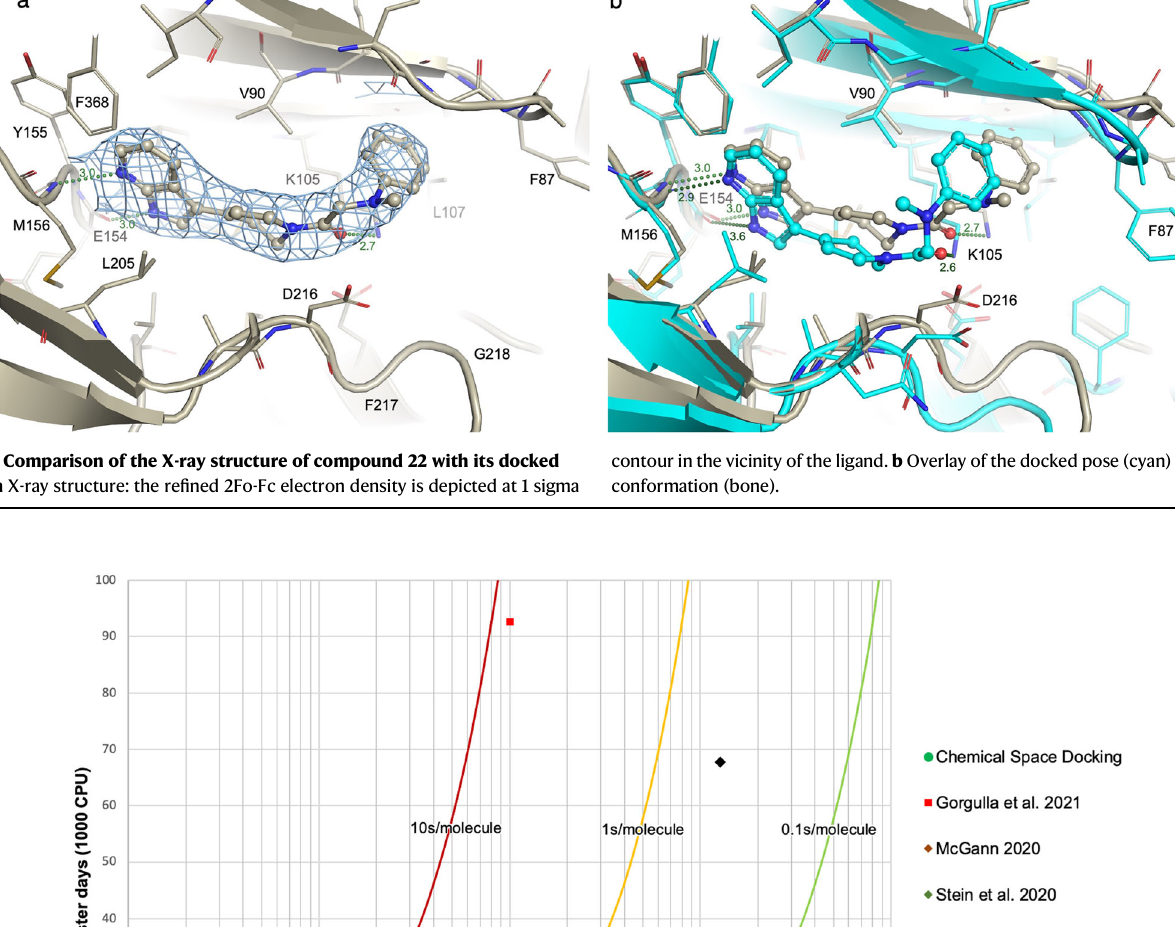
Docking curve shown in light blue. Large-scale docking campaigns from the lit- erature are shown as individual data points (including Space Docking results described here and similar campaigns) 1,2,26,27,40